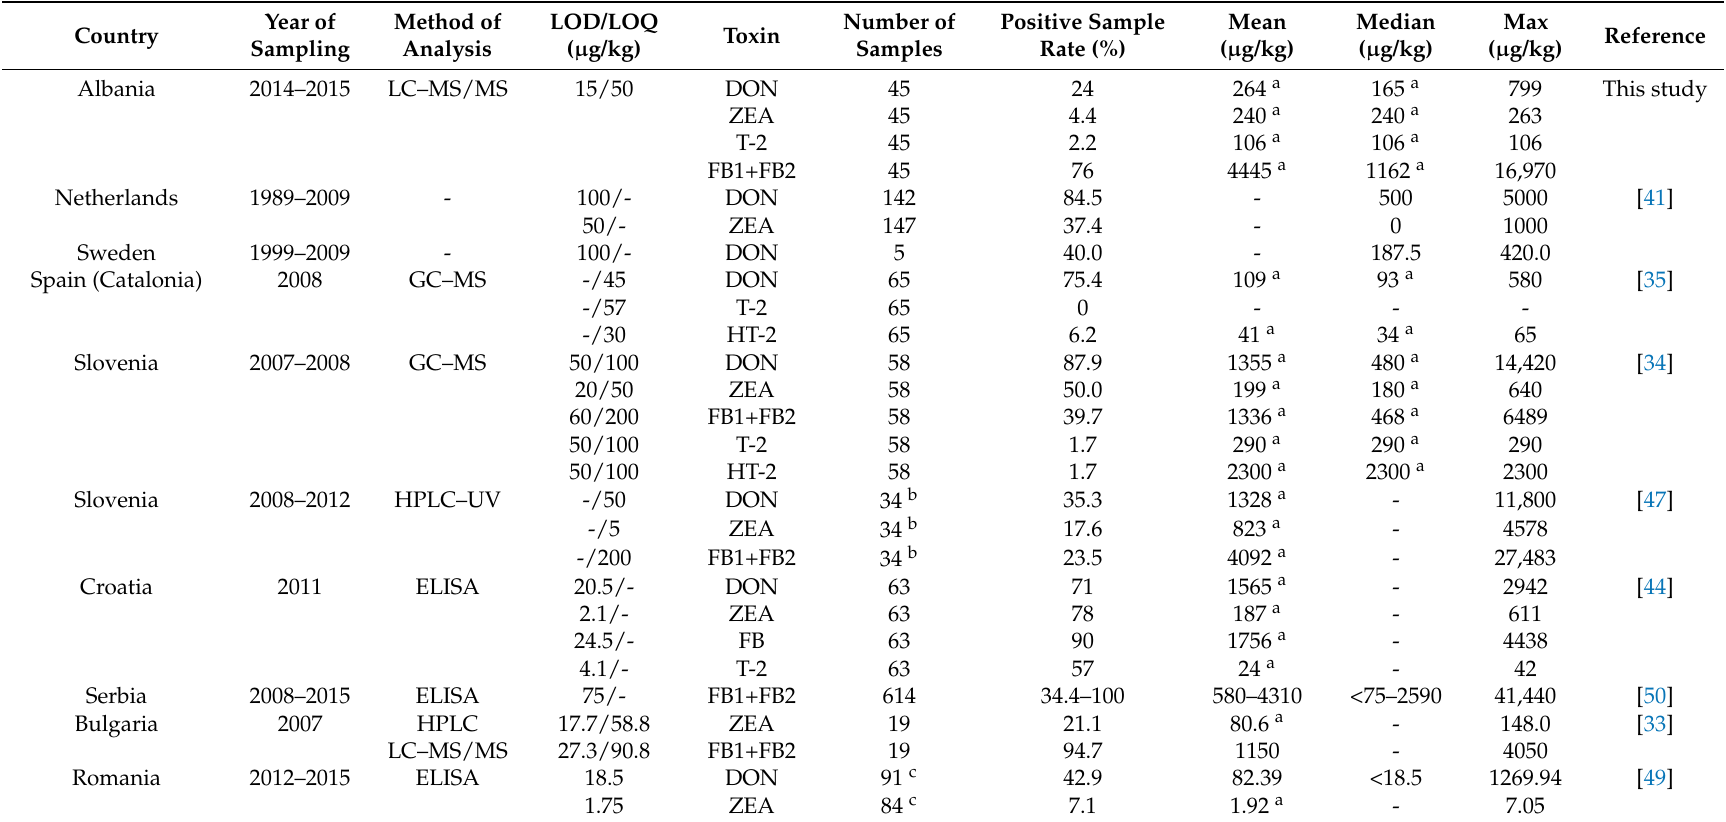
Table 6. Occurrence of Fusarium toxins in maize samples from different